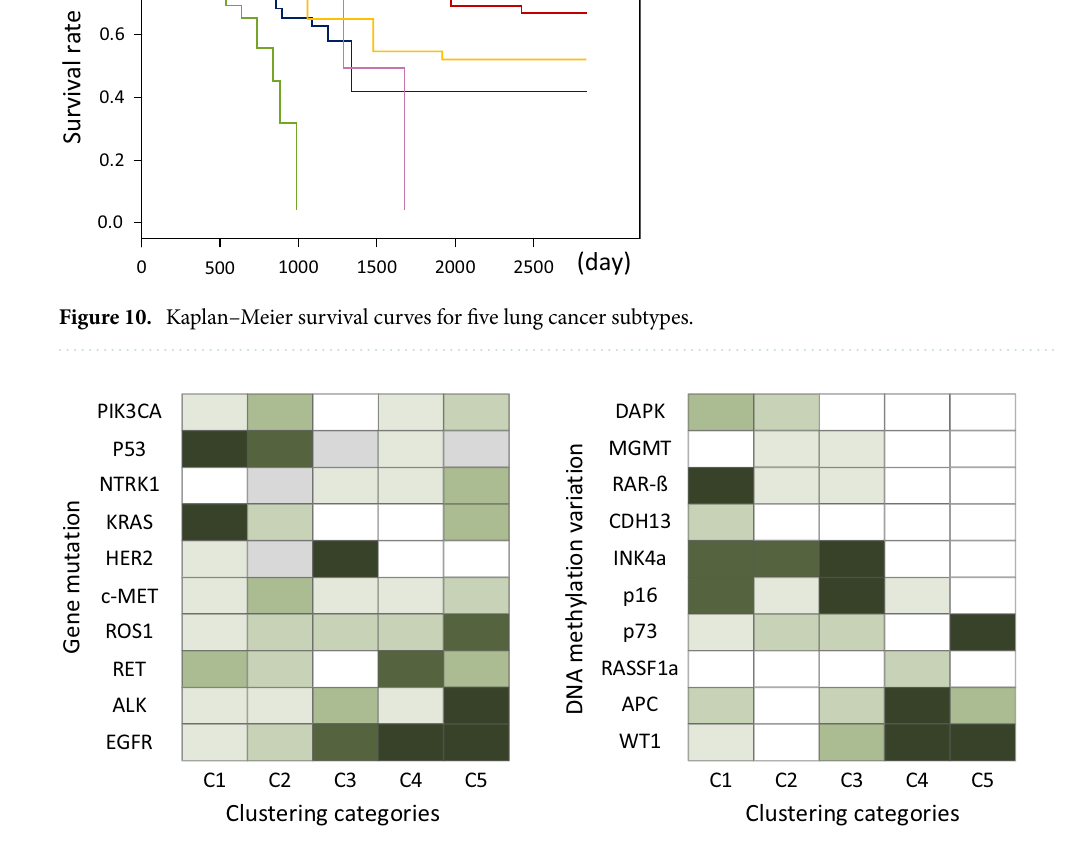
Figure 11. Lung cancer (partial) gene mutation and DNA methylation variation frequency map for every